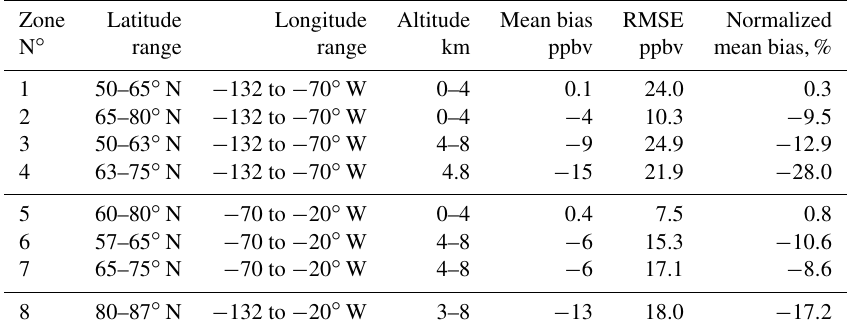
Table 5. Metrics of the WRF-Chem O 3 simulation performance for the regions reported in Table 4: mean bias, root mean square error (RMSE), normalized mean bias. Zone Latitude Longitude Altitude Mean bias